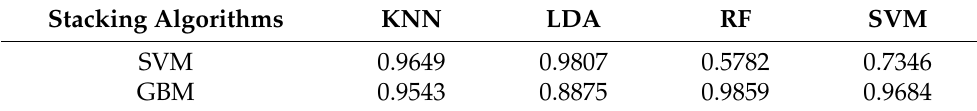
Table 7. Accuracy values of stacking algorithms for the kitchen gateway.